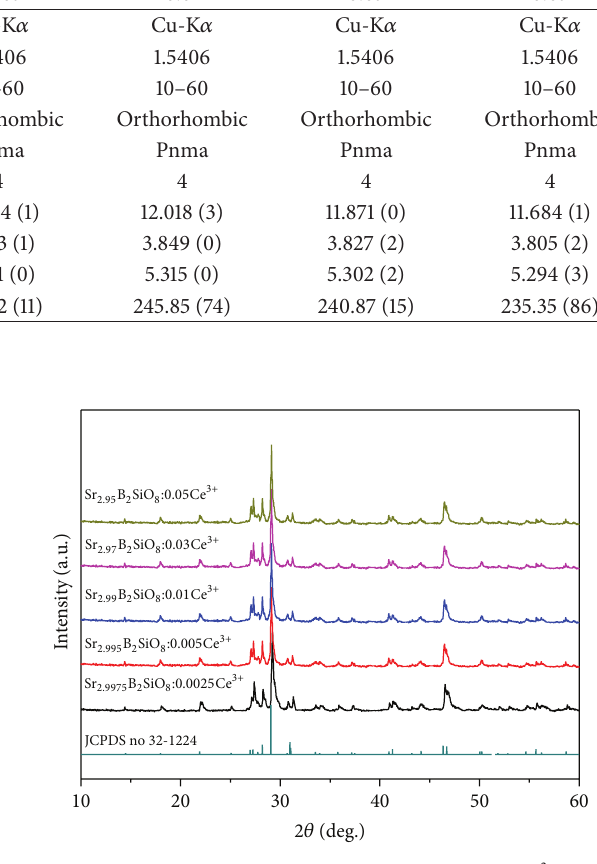
Figure 1: Typical XRD patterns of Sr 3−𝑥 B 2 SiO 8 : 𝑥 Ce 3+ .